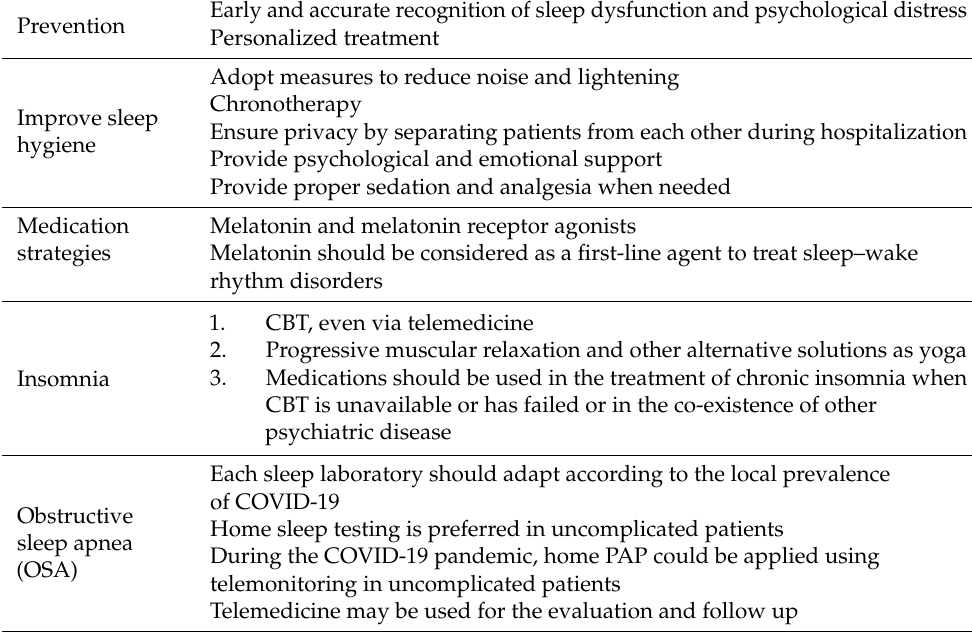
Table 3. Summary of the management of sleep disorders of COVID-19 patients [30,43,44,75–82,84–